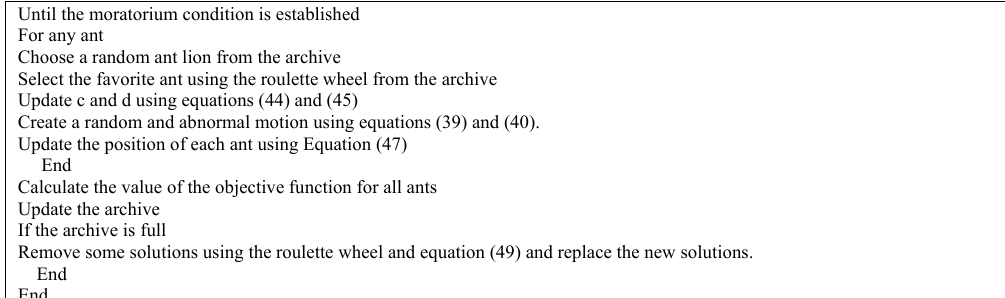
Fig. 3 . Pseudo code of Multi-objective ant-lion